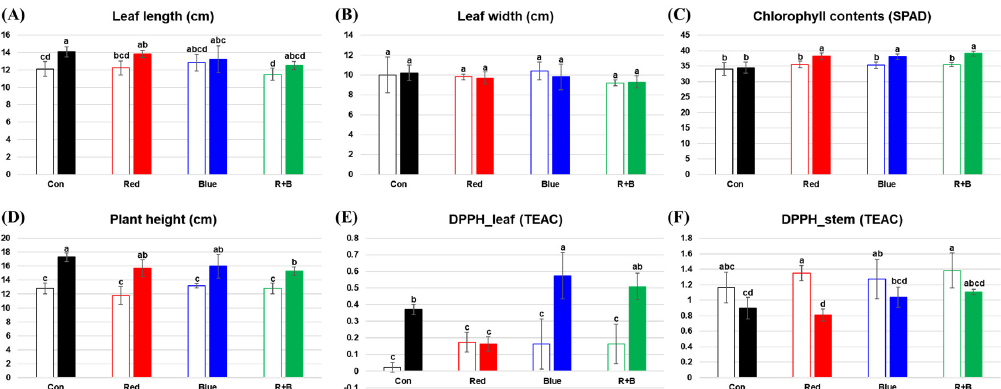
Figure 4. Leaf length ( A ), leaf width ( B ), chlorophyll content ( C ), plant height ( D ), and antioxidant activity ( E,F ) under different supplemental LED lighting conditions. Empty bars represent 10 days of